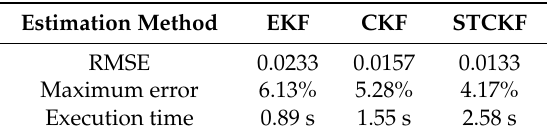
Table 3. Comparison of SOC estimation method under NEDC